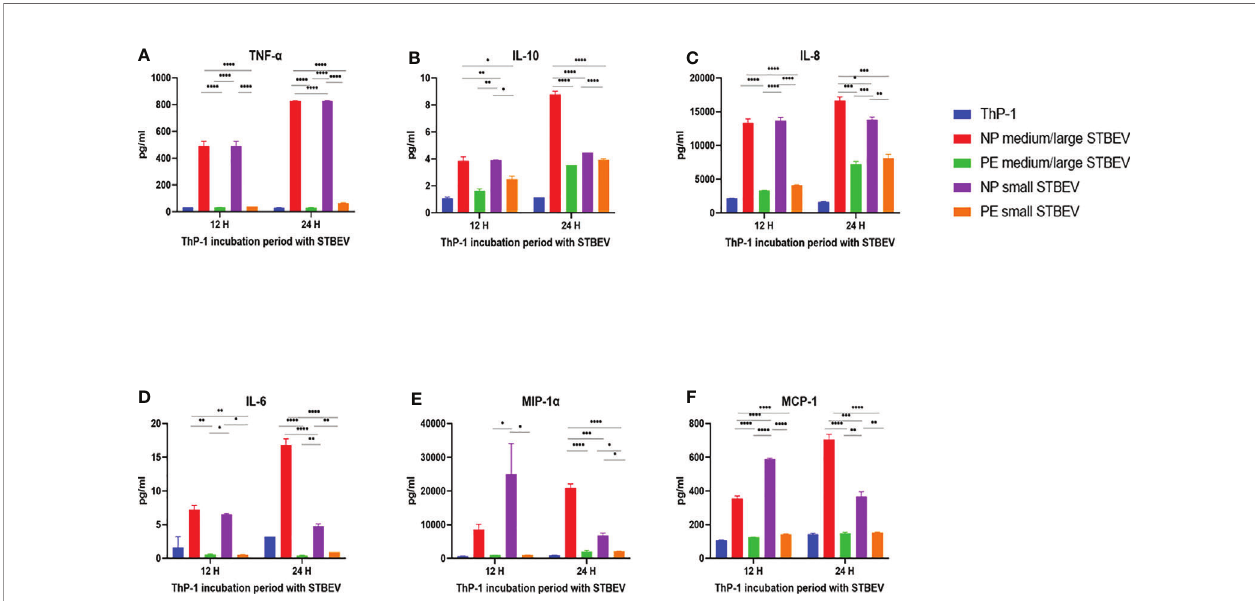
FIGURE 9 | Multiplex array analysis of the supernatants of differentiated THP-1 cells treated with STBEVs from NP and PE placentae. Concentrations of TNF- a (A) , IL-10 (B) , IL-8 (C) , IL-6 (D) , MIP- a (E) , MCP-1 (F) released by THP-1 cells at 12 and 24 h incubation with STBEVs. Values calculated as Mean ± SEM of value from cells treated with 1 X 10 9 of STBEVs. Bars without error bars represent data whose SEM are close to zero and could not be adequately plotted by prism. To determine signi fi cant difference in production, a one-way ANOVA was performed on data: *p ≤ 0.05, **p ≤ 0.01, ***p ≤ 0.001 and ****p ≤